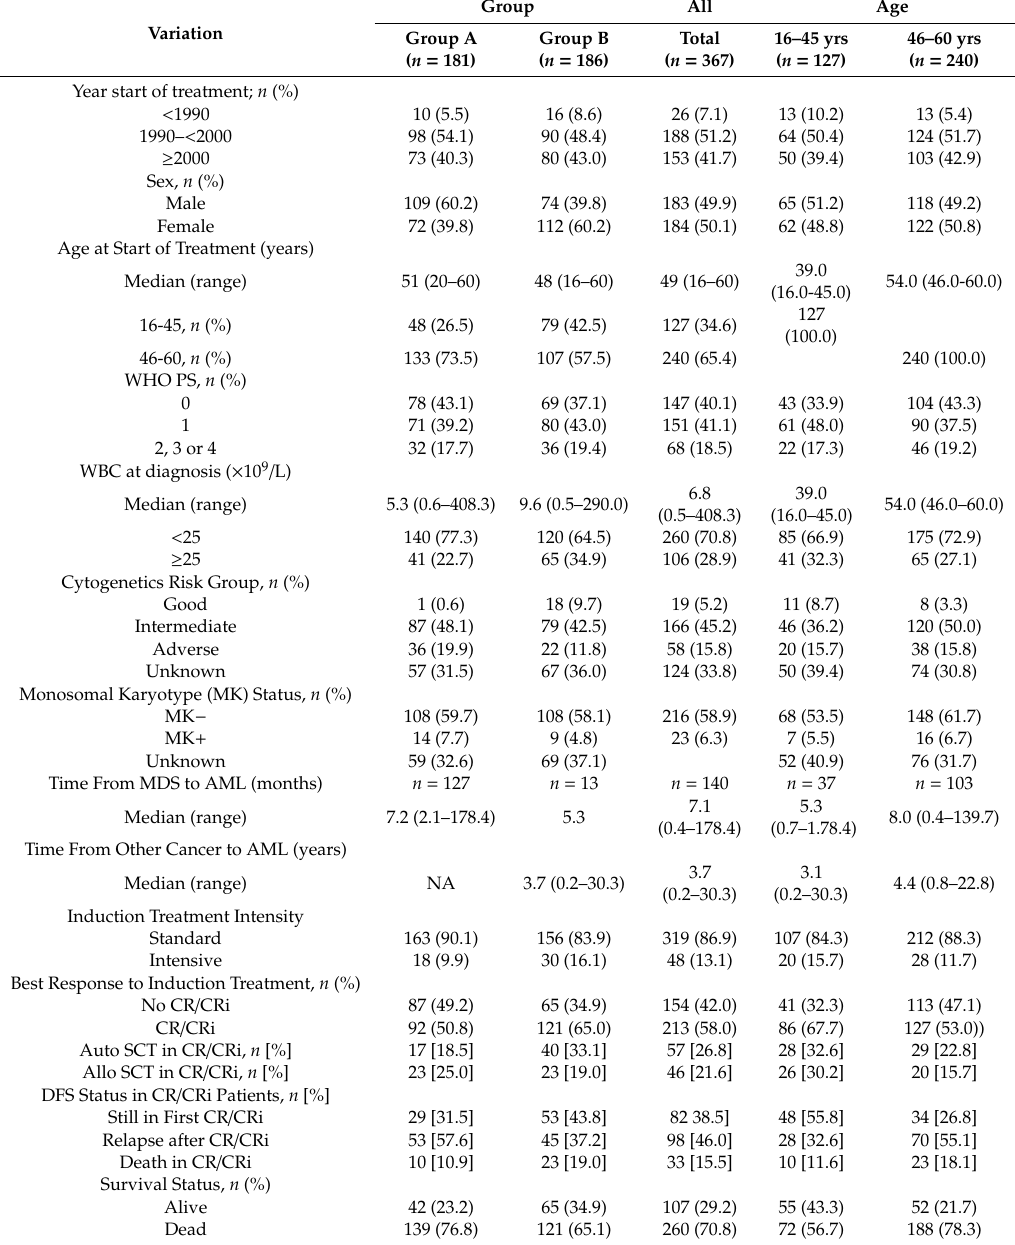
Table 1. Baseline characteristics, treatment period and intensity, autologous stem cell transplantation (auto-SCT) and allo-SCT applicability and outcomes in patients with s-AML following MDS (group A) or other malignancies (group B), aged 16–60 years at the start of